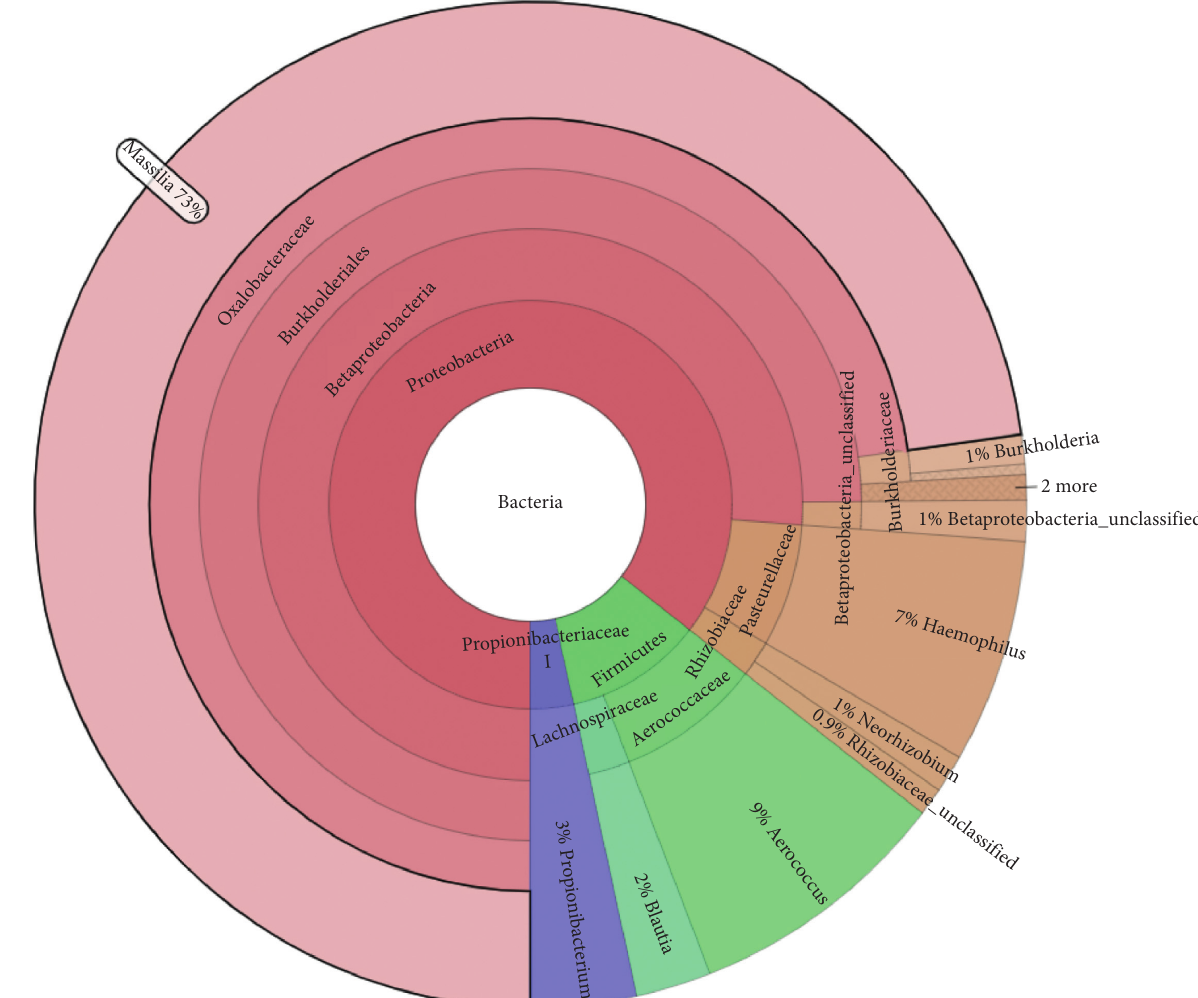
Figure 2: Different OTUs between prostatitis-like symptoms men and fertile men. Semen and urine samples from chronic prostatitis symptoms and fertile men differ statistically in 14 OTU. Most of them are not detectable by traditional culture techniques, which show the importance of sequencing in the study of prostate